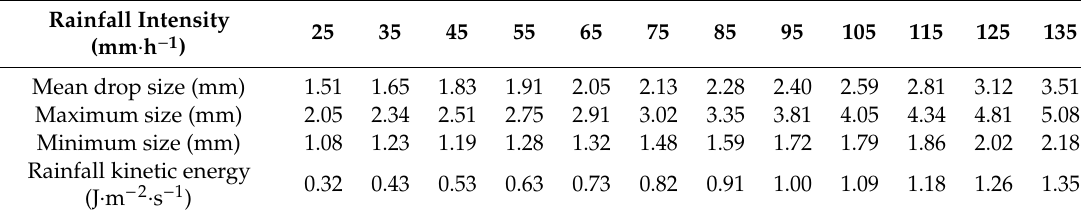
Table 2. Raindrop diameter and rainfall kinetic energy under di ff erent rain